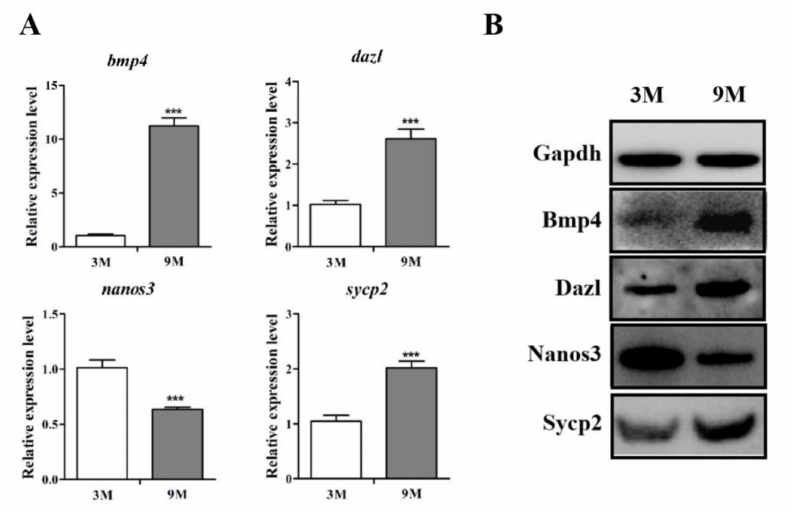
Figure 2. The expression levels of bmp4, dazl, nanos3 and sycp2 in sheep testicular development. ( A , B ) represent the mRNA and protein expression levels of bmp4, dazl , nanos3 and sycp2 in the 3M and 9M group using qPCR and Western blot, respectively. qPCR results were expressed relative to the 3M group as mean values ± the SEM. *** indicates extremely significant differences between groups ( p < 0.001); 3M and 9M refer to 3-month-old and 9-month-old testis tissues of sheep, respectively.